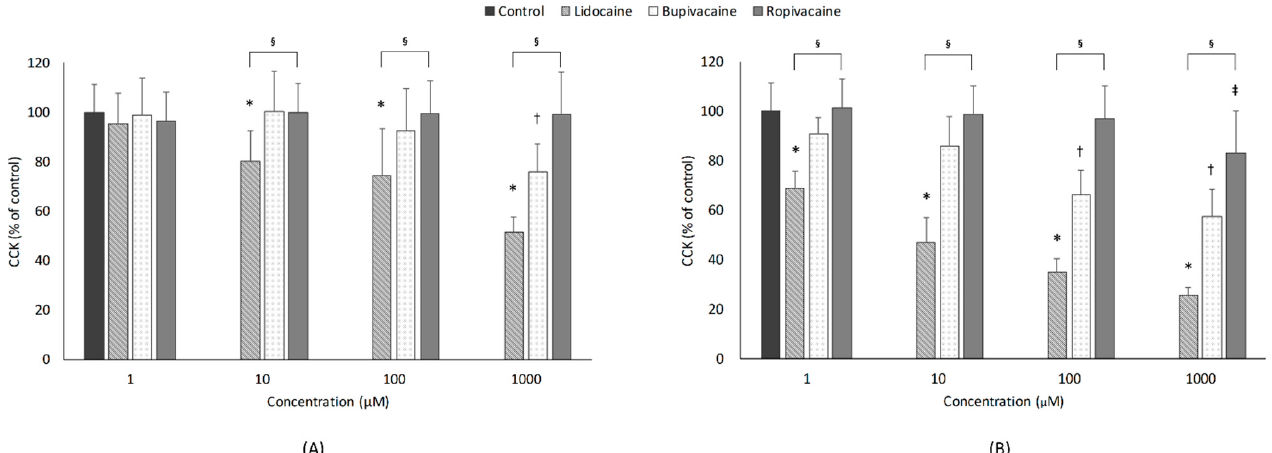
Figure 1. Effects of local anesthetics on cell viability, which was assessed with cell counting kit 8 (CCK-8) assay. Developing motor neurons were exposed to the indicated concentrations (1, 10, 100, or 1000 µ M) of local anesthetics for ( A ) 1 h or ( B ) 24 h. All data are expressed as means ± standard deviations. Differences between the results were evaluated by two-way ANOVA, followed by Dunnett’s test for multiple comparisons. * p < 0.05, lidocaine vs. control group. † p < 0.05, bupivacaine vs. control group. ‡ p < 0.05, ropivacaine vs. control group. § p < 0.05, differences among the 3 groups by ANOVA.